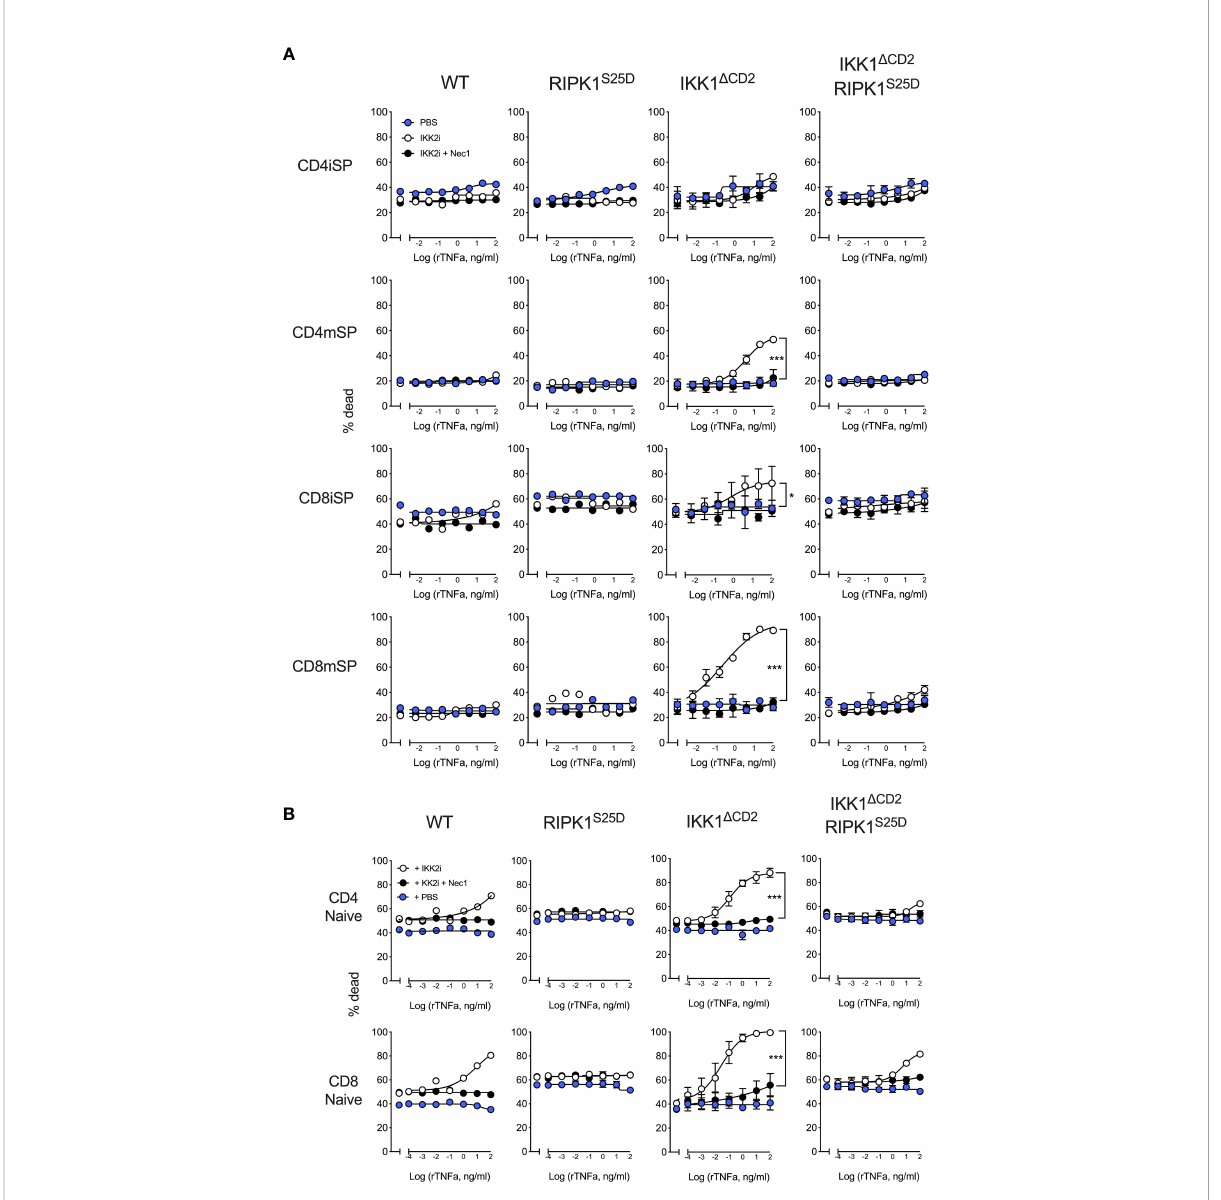
FIGURE 2 TNF induced cell death in the absence of IKK kinase activity is blocked by RIPK1 S25D in thymocytes and peripheral naive T cells. Thymus and LN cells from IKK1 D CD2 and IKK1 D CD2 RIPK1 S25D mice, and iCre -ve litter mates (WT or RIPK1 S25D columns), were cultured for 24h at different doses of TNF with addition of either IKK2i (10µM), IKK2i + Nec1 (10nM), or PBS as control. Cultured cells were analysed by fl ow cytometry and % dead cells calculated and graphed for the indicated populations of thymocytes (A) and peripheral naive T cells (B) . Data are representative of three or more independent replicate experiments. Error bars show s.d. Signi fi cant differences between PBS and IKK2i conditions were determined by 2- way ANOVA. * < 0.05, *** <